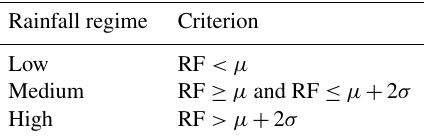
Table 4. Segregation of overall rainfall time series into low, medium and high rainfall time series (RF is rainfall, µ is mean of rainfall, and σ is standard deviation of